Question: Write a descriptive caption for this figure.
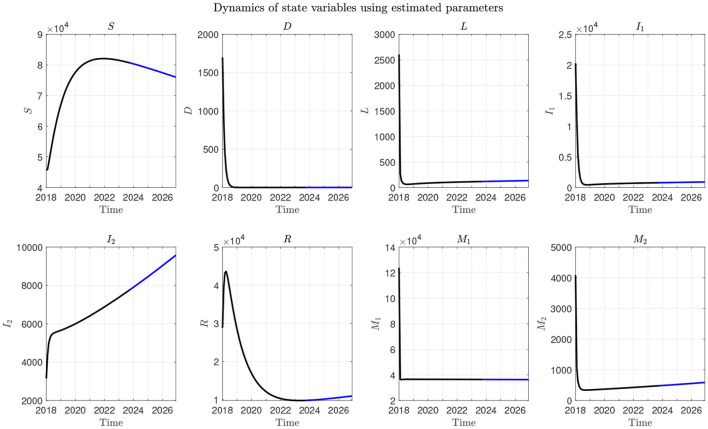
Answer: Model output of system Equation 12 using the estimated parameter values. The black curve represents the model output before November 2023, while the blue curve shows the extension up to December 2026.